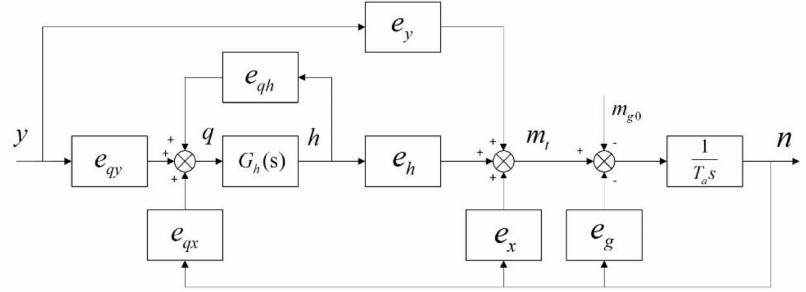
Figure 7. Block diagram of pumped-storage